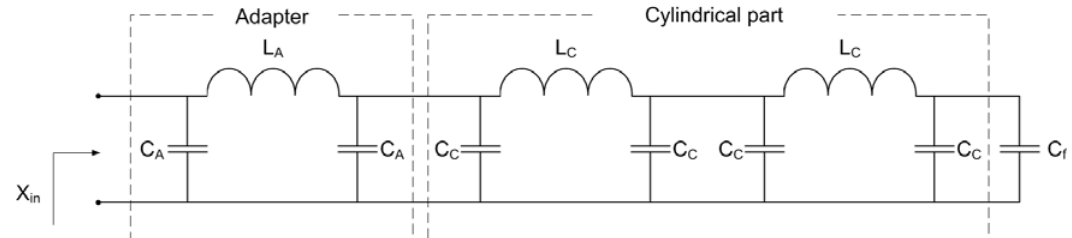
Figure 6. Lumped element model of the proposed